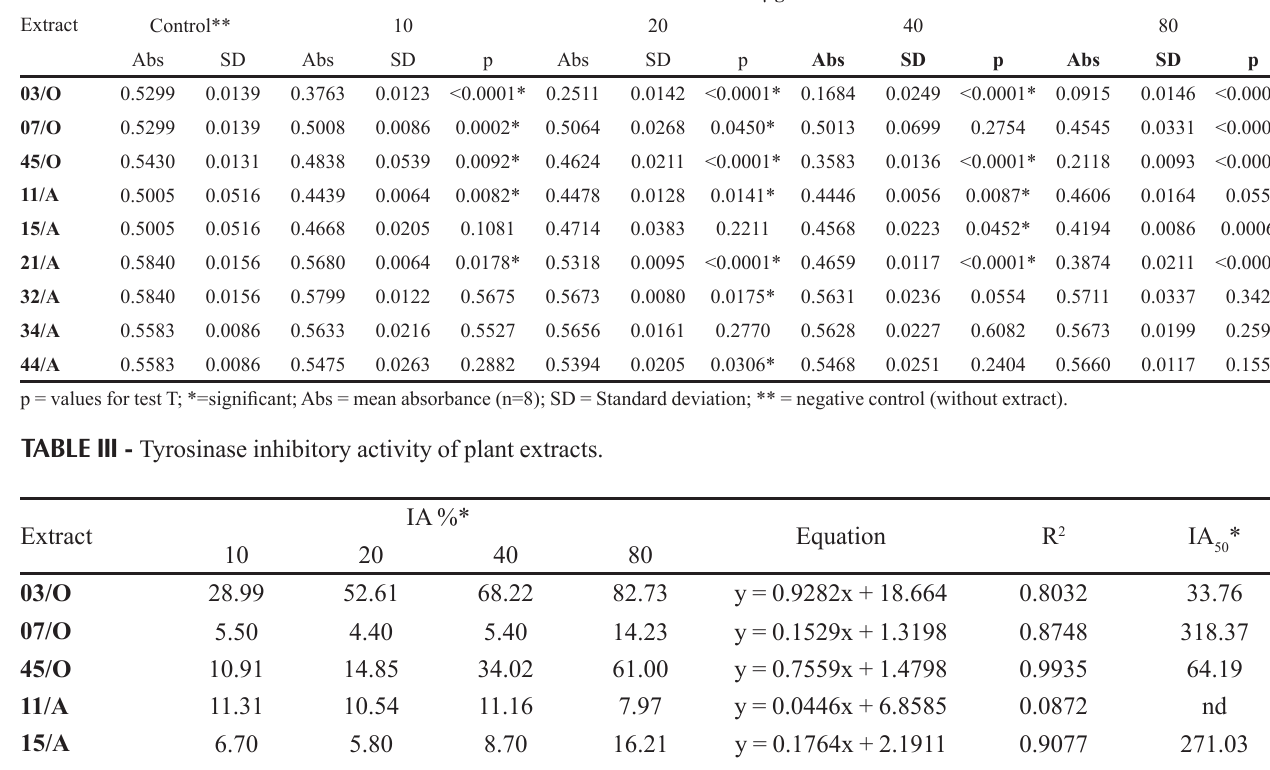
TABLE II - Tyrosinase reaction in the presence of plant extracts at different concentrations after 60 minutes of exposure Extract concentration m g.mL -1 Extract Control**